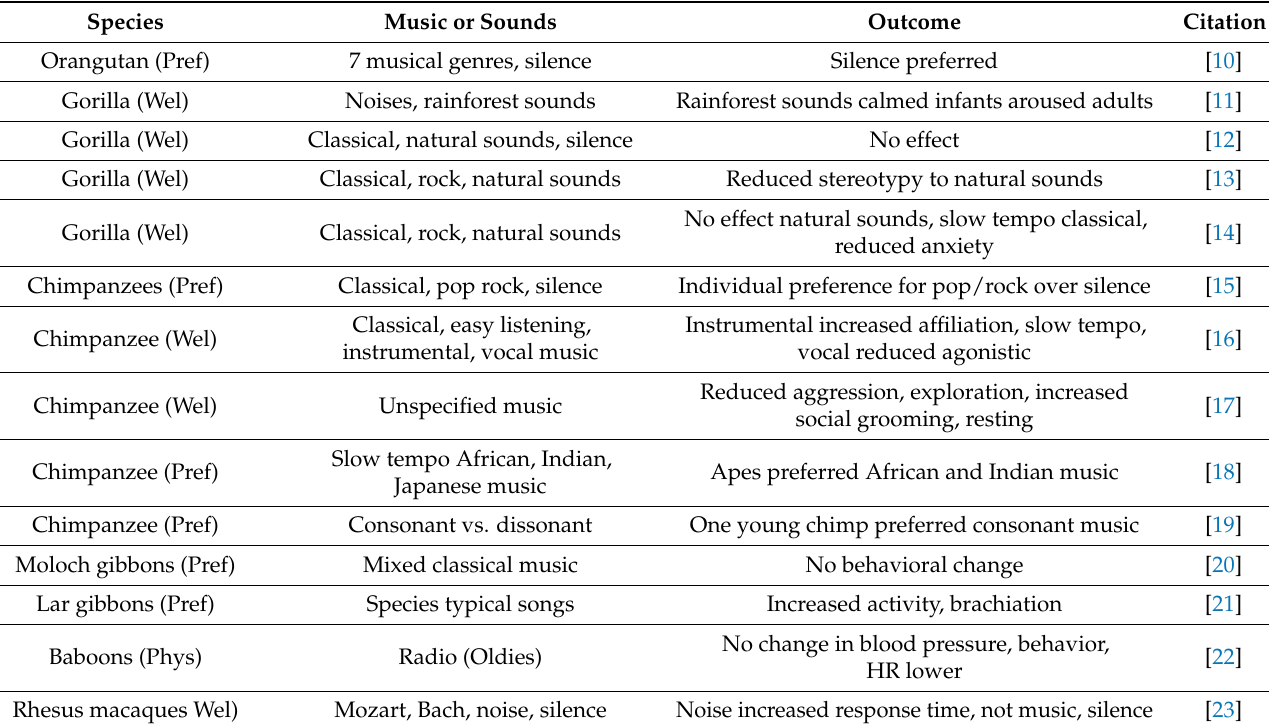
Table 1. Effects of Music and Other Sounds on Animals